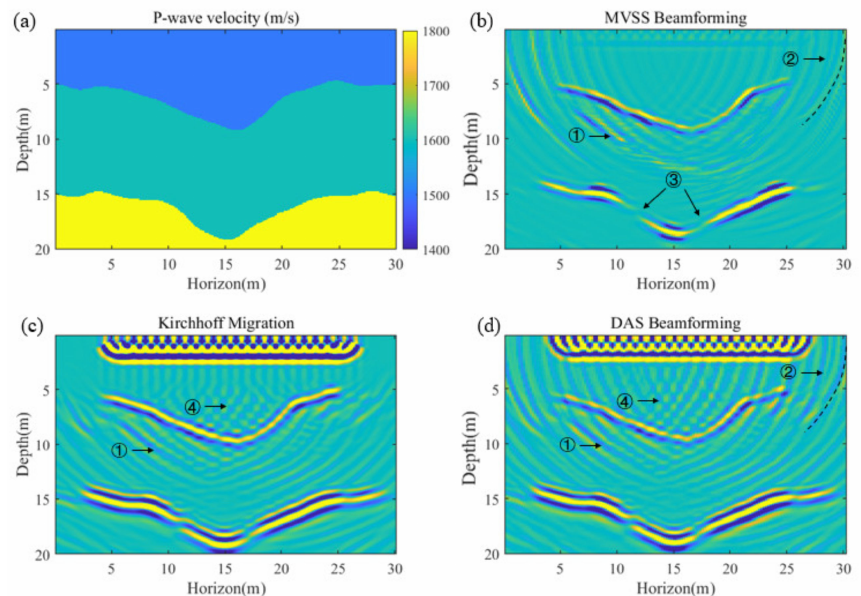
Figure 13. Model B-1. ( a ) True velocity model. ( b ) Imaging result of MVSS beamforming. ( c ) Imaging result of Kirchhoff migration. ( d ) Imaging result of DAS